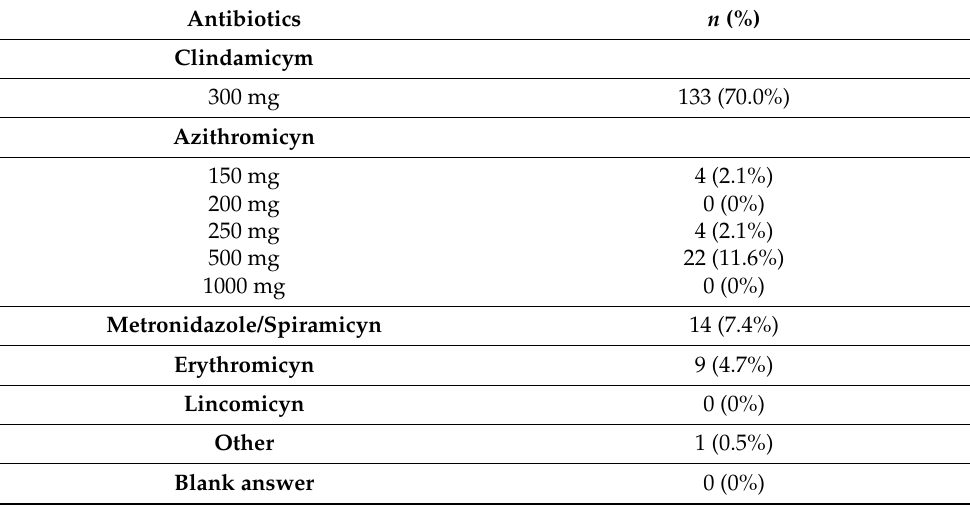
Table 3. Antibiotic preference in patients with medical allergies.